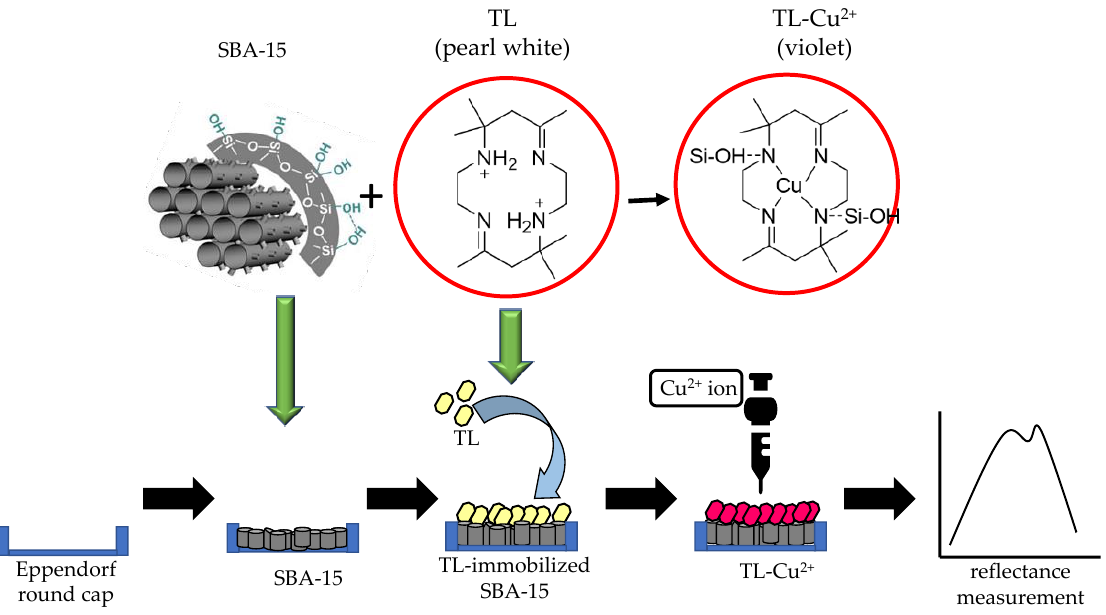
Figure 1. Stepwise process for the fabrication of Cu 2+ ion sensor based on SBA15 as immobilization matrix and TL as sensing reagent. Chemical reaction of TL with Cu 2+ ion presenting color change from pearl white to violet and quantified with reflectance measurement.